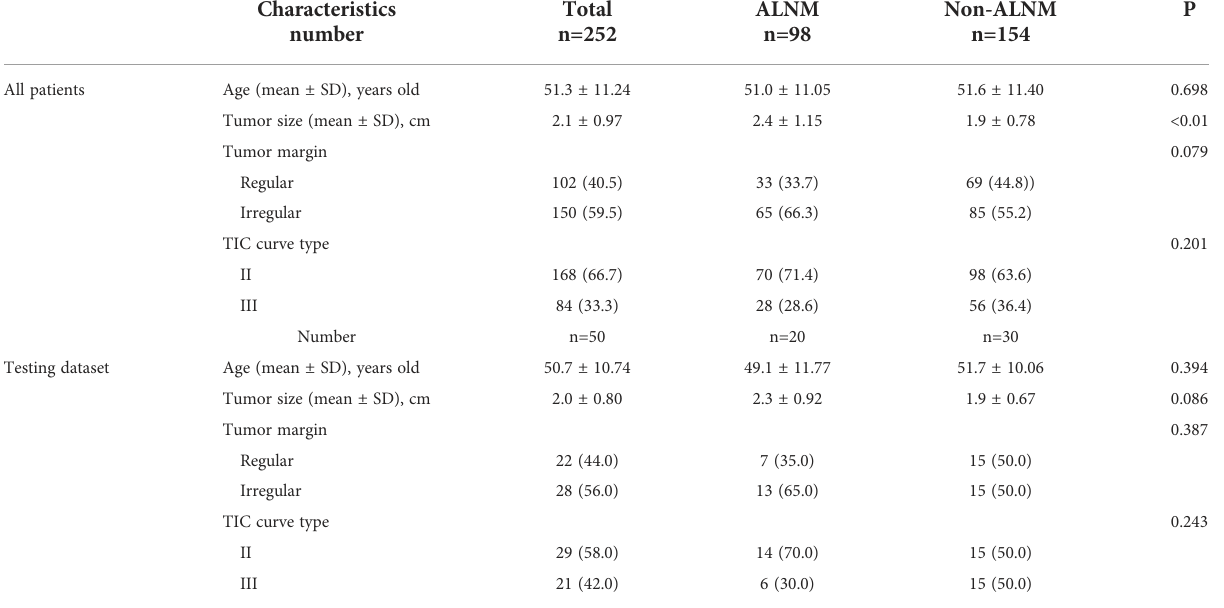
TABLE 1 Population